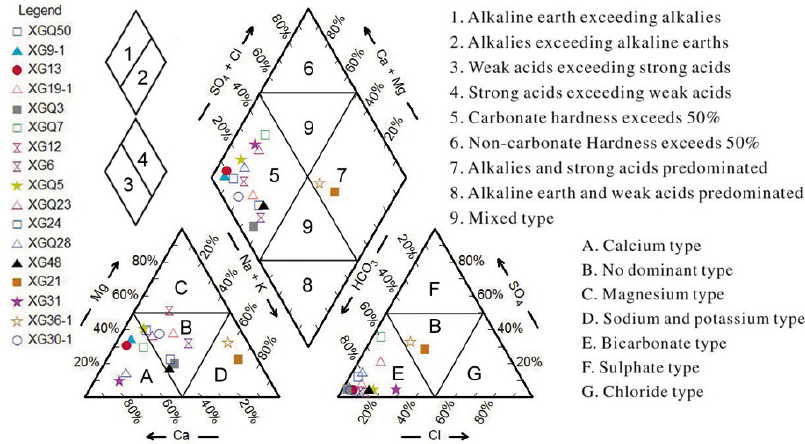
Figure 2. Piper diagram of groundwater samples.